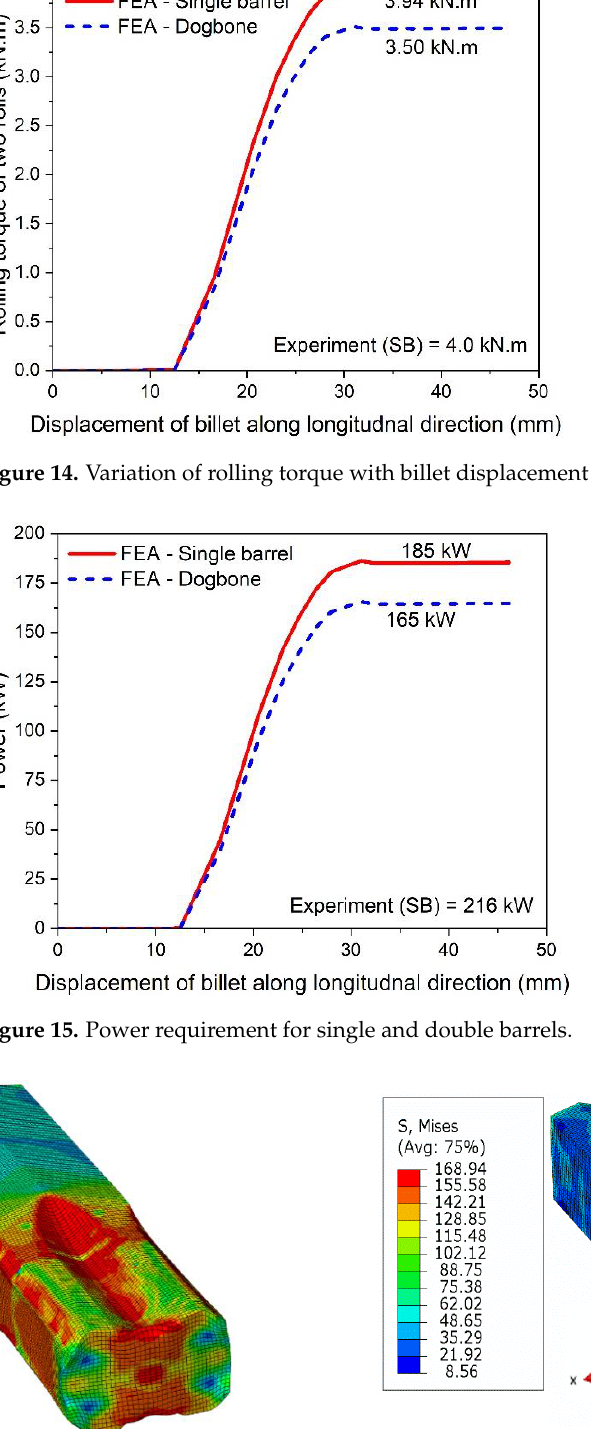
( b ) Figure 17. Equivalent plastic strain (PEEQ) distribution: ( a ) single barrel, ( b ) double barrel. ( a ) ( b ) Figure 18. Maximum principal logarithmic strain distribution: ( a ) single barrel, ( b ) double barrel.